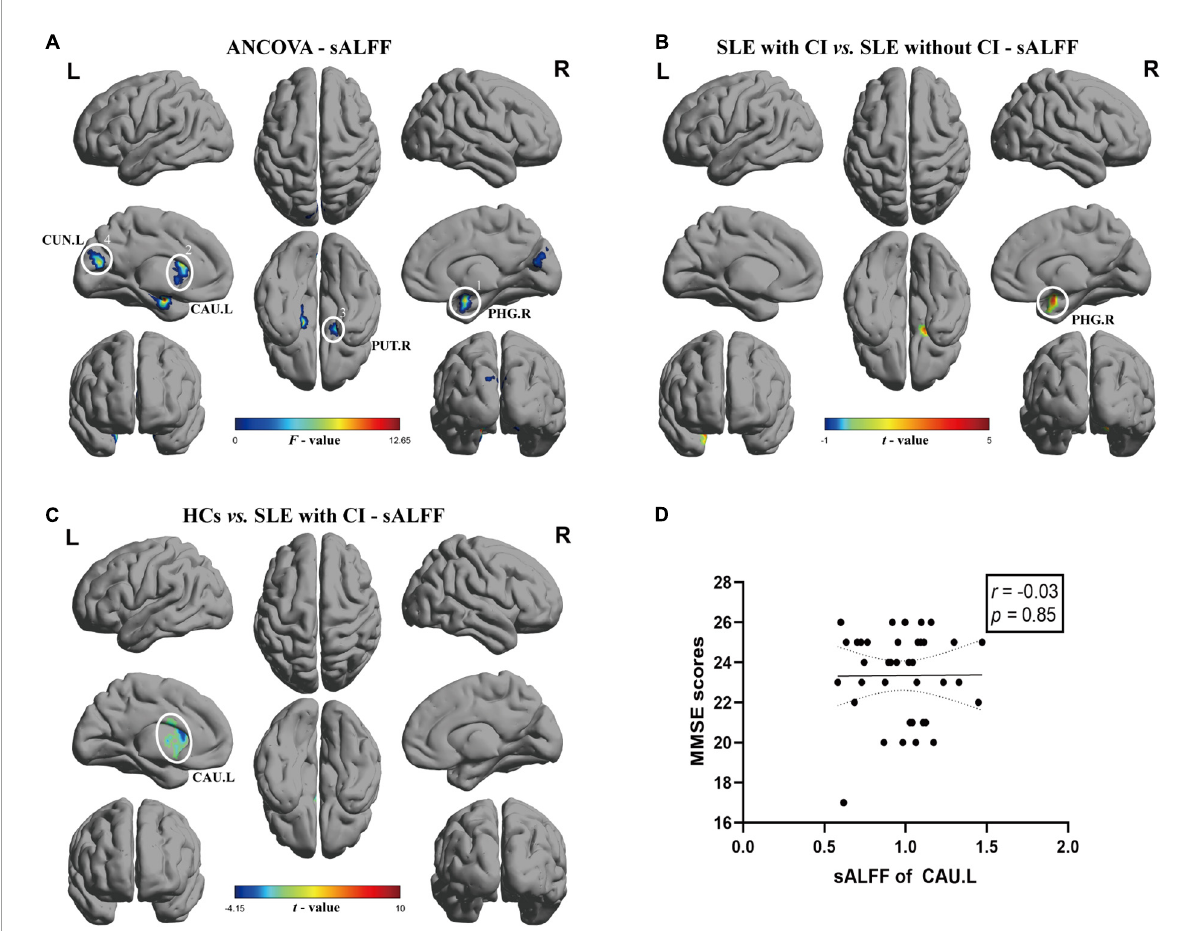
FIGURE1 Brain regions with significant differences of sALFF among SLE with CI, SLE without CI and HCs. Specifically, (A) ANCOVA results of sALFF among three groups (voxel P < 0.01, cluster P < 0.05, controlling for age, gender and head motion, GRF corrected), (B,C) Differences between the groups were calculated using post-hoc analysis based on a two-sample t -test (voxel P < 0.01, cluster P < 0.05, controlling for age, gender, and head motion, GRF corrected). (D) Correlation analysis showed no significant correlation was found between sALFF and MMSE scores in SLE with CI groups. Color bars represent statistical value; the solid lines and dashed lines represented the linear regression fitted line and 95% confidence interval of the Spearman correlation analysis, respectively, SLE with CI, systemic lupus erythematosus patients with cognitive impairment; SLE without CI, systemic lupus erythematosus patients without cognitive impairment; HCs, healthy controls; sALFF, static amplitudes of low-frequency fluctuation; MMSE, Mini-mental State Examination; L, left hemisphere; R, right hemisphere; PHG, parahippocampal gurys; CAU, caudate nucleus; PUT, lenticular nucleus, putamen; CUN,